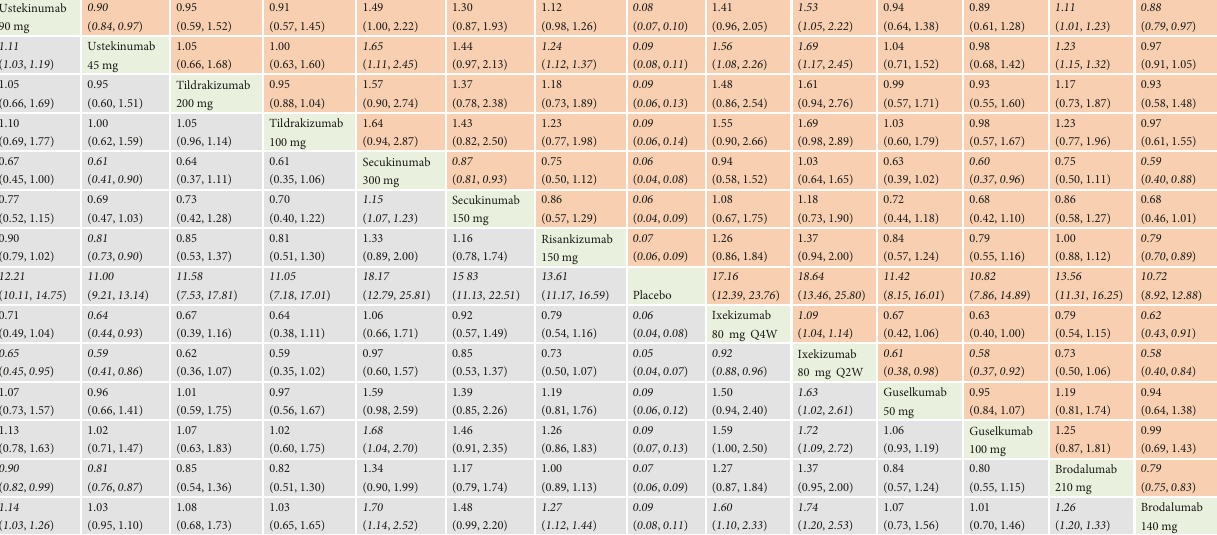
Figure 4: Relative risk with 95% CIs of all interventions from network meta-analysis for PASI 75. Di ff erent interventions in the middle block divide the graph into upper and lower triangles; for the lower triangle, the e ffi cacy estimate is the ratio of the column de fi ning treatment to the row de fi ning treatment. In case that the con fi dence interval does not include 1, if RR > 1 , it favors the column de fi ning treatment. In contrast, if RR < 1 , it favors the row de fi ning treatment. The upper triangle is symmetrical to the lower triangle. The e ffi cacy estimate is the ratio of the row de fi ning treatment to the column de fi ning treatment. The results are mutually reciprocal. Statistically signi fi cant results have been applied with italic formatting.